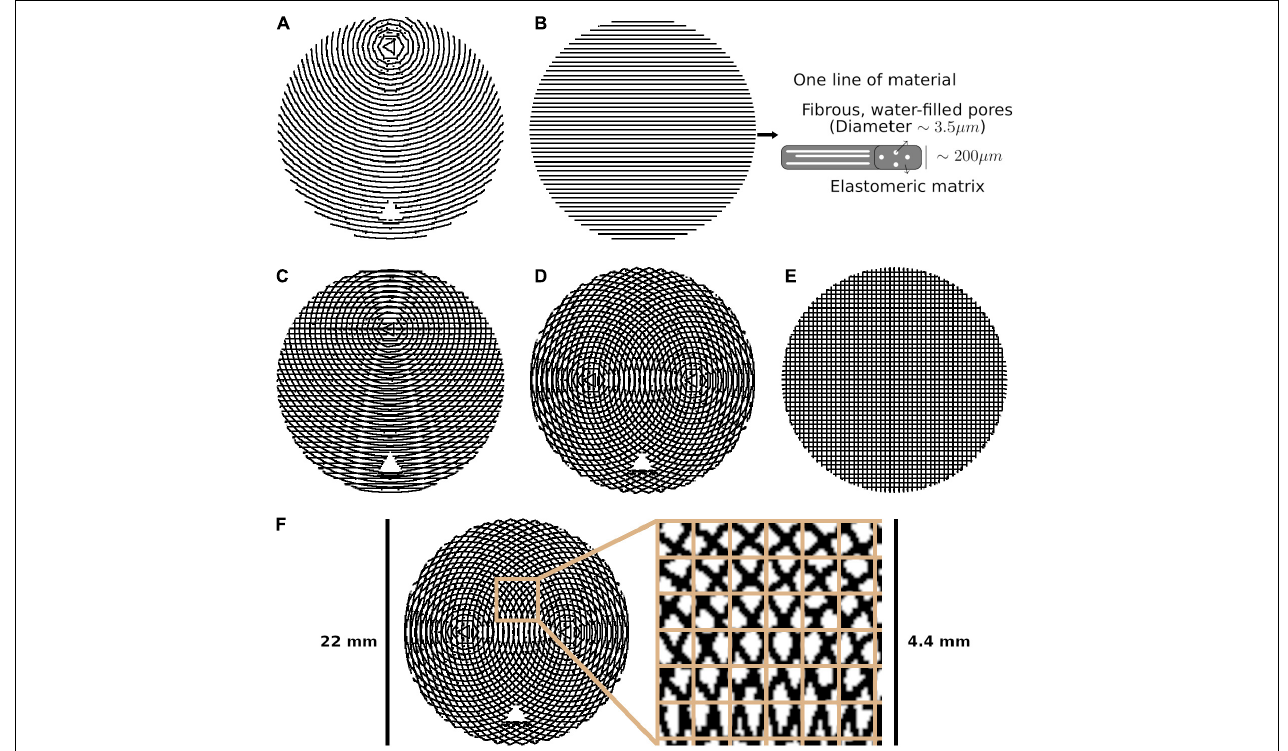
FIGURE 1 | The five phantom patterns, with alternating layers superimposed on one another. (A) Bending. (B) Straight, with a schematic of one line of material. (C) Kissing. (D) Fanning. (E) Crossing. (F) Crossing, with the isotropic in-plane voxel size overlaid on a cut-out.